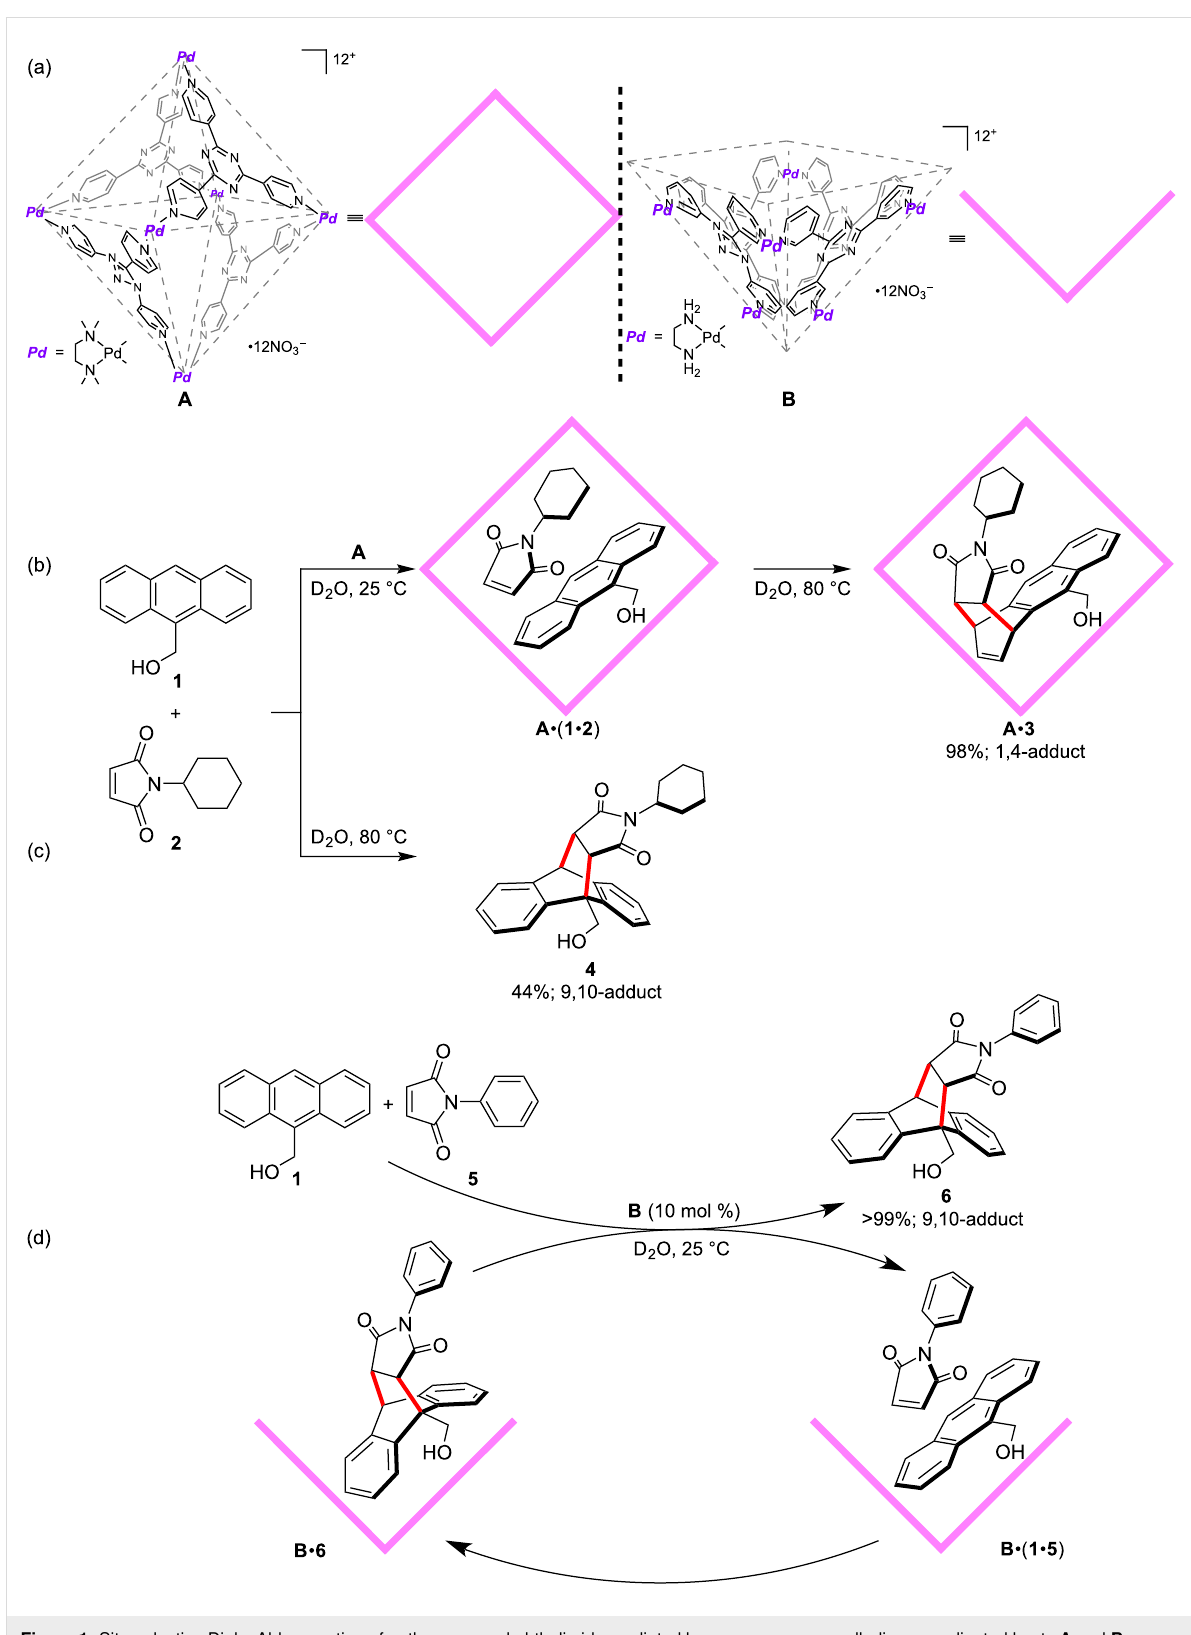
Figure 1: Site-selective Diels–Alder reaction of anthracene and phthalimide mediated by aqueous organopalladium-coordinated hosts A and B